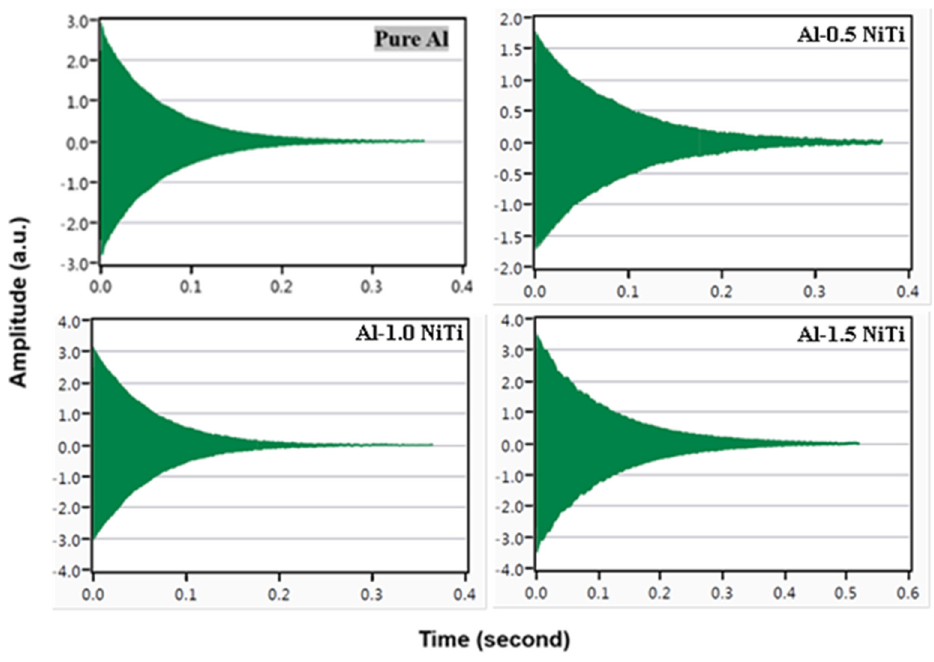
Figure 7. Damping characteristics of pure Al and Al (0.5, 1, and 1.5 vol %) NiTi nanocomposites. Table 2. Elastic modulus and damping characteristics of extruded Al-NiTi nanocomposites. Damping Composition